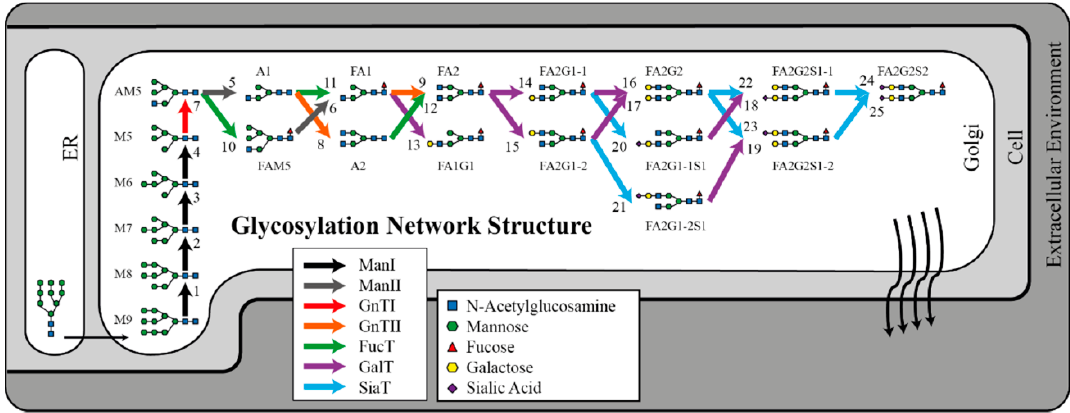
Figure 6. Glycosylation network for the GFA of immunoglobulin G in CHO-S. The enzyme names are abbreviated as follows: α -Mannosidase I and II (Man I/II), N -Acetylglucosaminyltransferase I and II